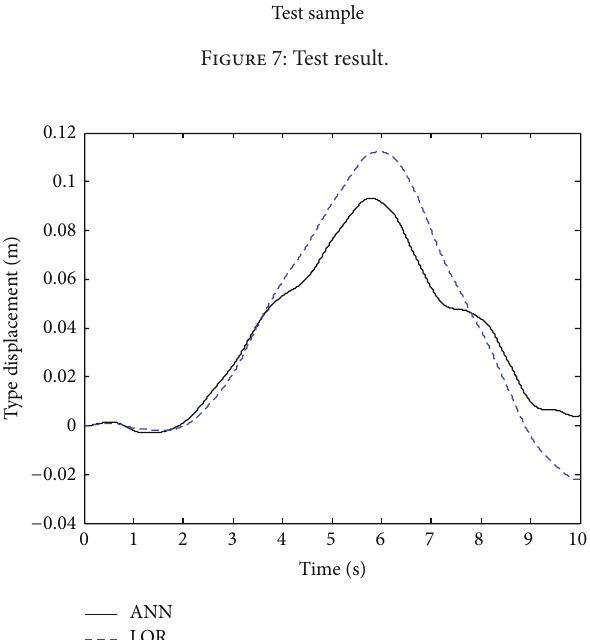
Figure 7: Test result.